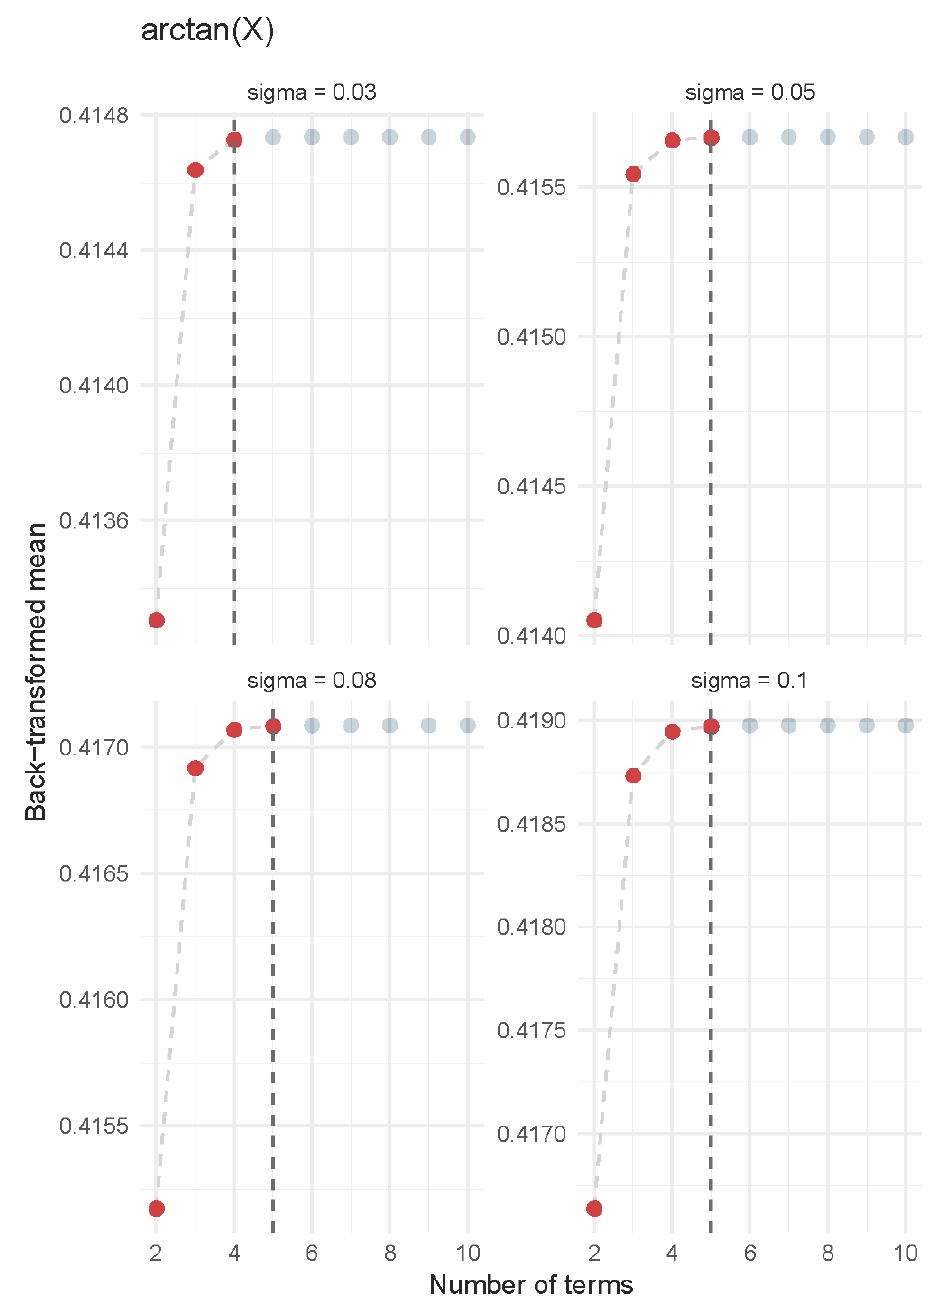
Figure 6. Convergence of the arctangent transformation according to the number of terms in the Table 1.